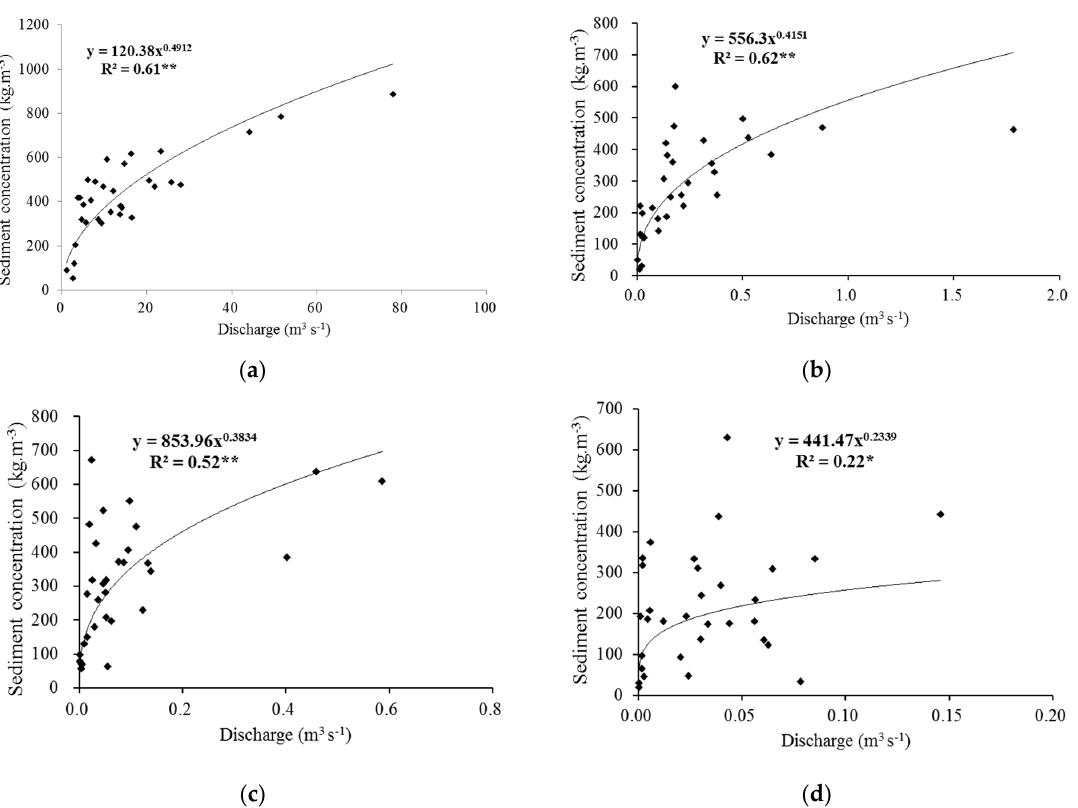
Figure 4. SSC–Q relationships of different geomorphic units at flood event timescale. ( a ) Peijiamao watershed; ( b ) Qiaogou gully; ( c ) first branch of Qiaogou gully (subgully); ( d ) whole slope. Note: **